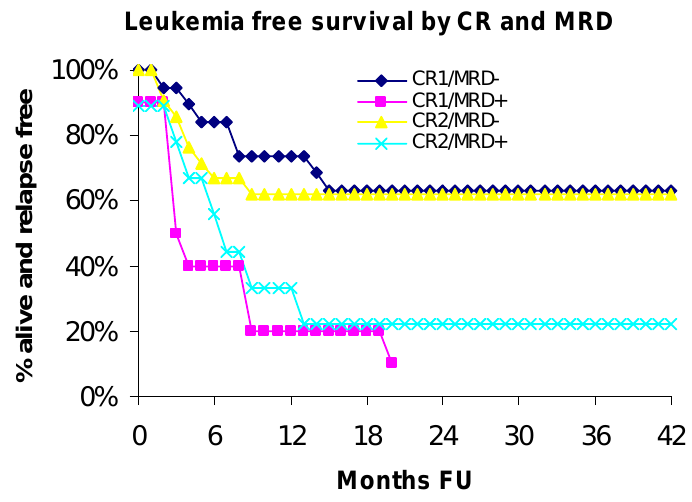
Figure 2. Leukemia free survival by CR and MRD. Leukemia free survival by CR and